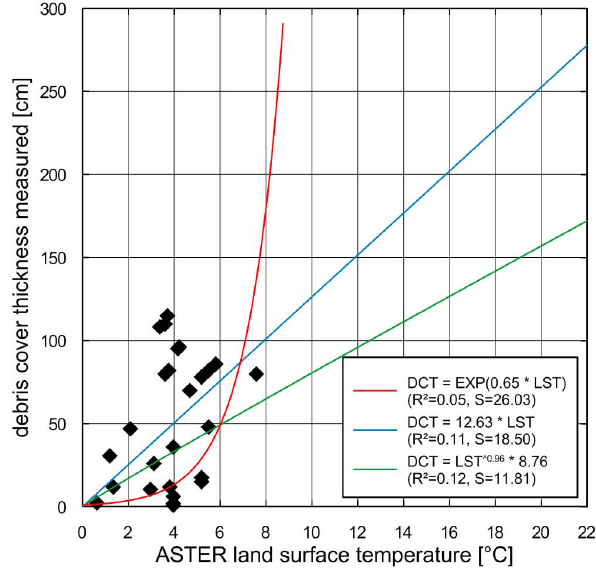
Fig. 4. Debris cover thickness (DCT) vs. ASTER LST with three different regression methods. R 2 is the coefficient of determination and S is the standard error of the